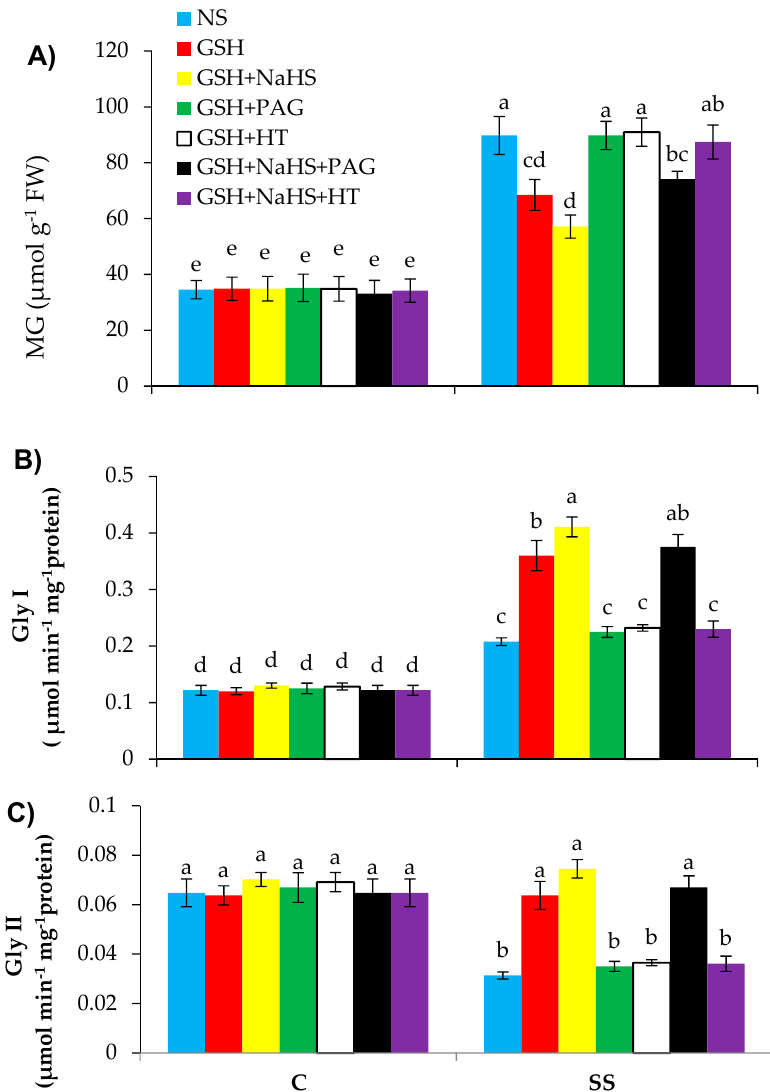
Figure 10. Methylglyoxal (MG ( A )) content, glyoxalase I (Gly I ( B )), and glyoxalase II (Gly II ( C )) in pepper plants grown under control (C) and salinity stress (SS 100 mmol L − 1 NaCl), sprayed with glutathione (1.0 mmol L − 1 GSH) or sodium hydrosulfide (0.2 mmol L − 1 NaHS) alone or together, combined with a 0.1 mmol L − 1 scavenger of H 2 S, hypotaurine (0.1 mmol L − 1 HT), or inhibitor of L -DES, DL -propargylglycine (0.3 mmol L − 1 PAG). (Mean ± SE). Mean values carrying different letters within each parameter differ significantly ( p ≤ 0.001) based on Duncan’s multiple range test.